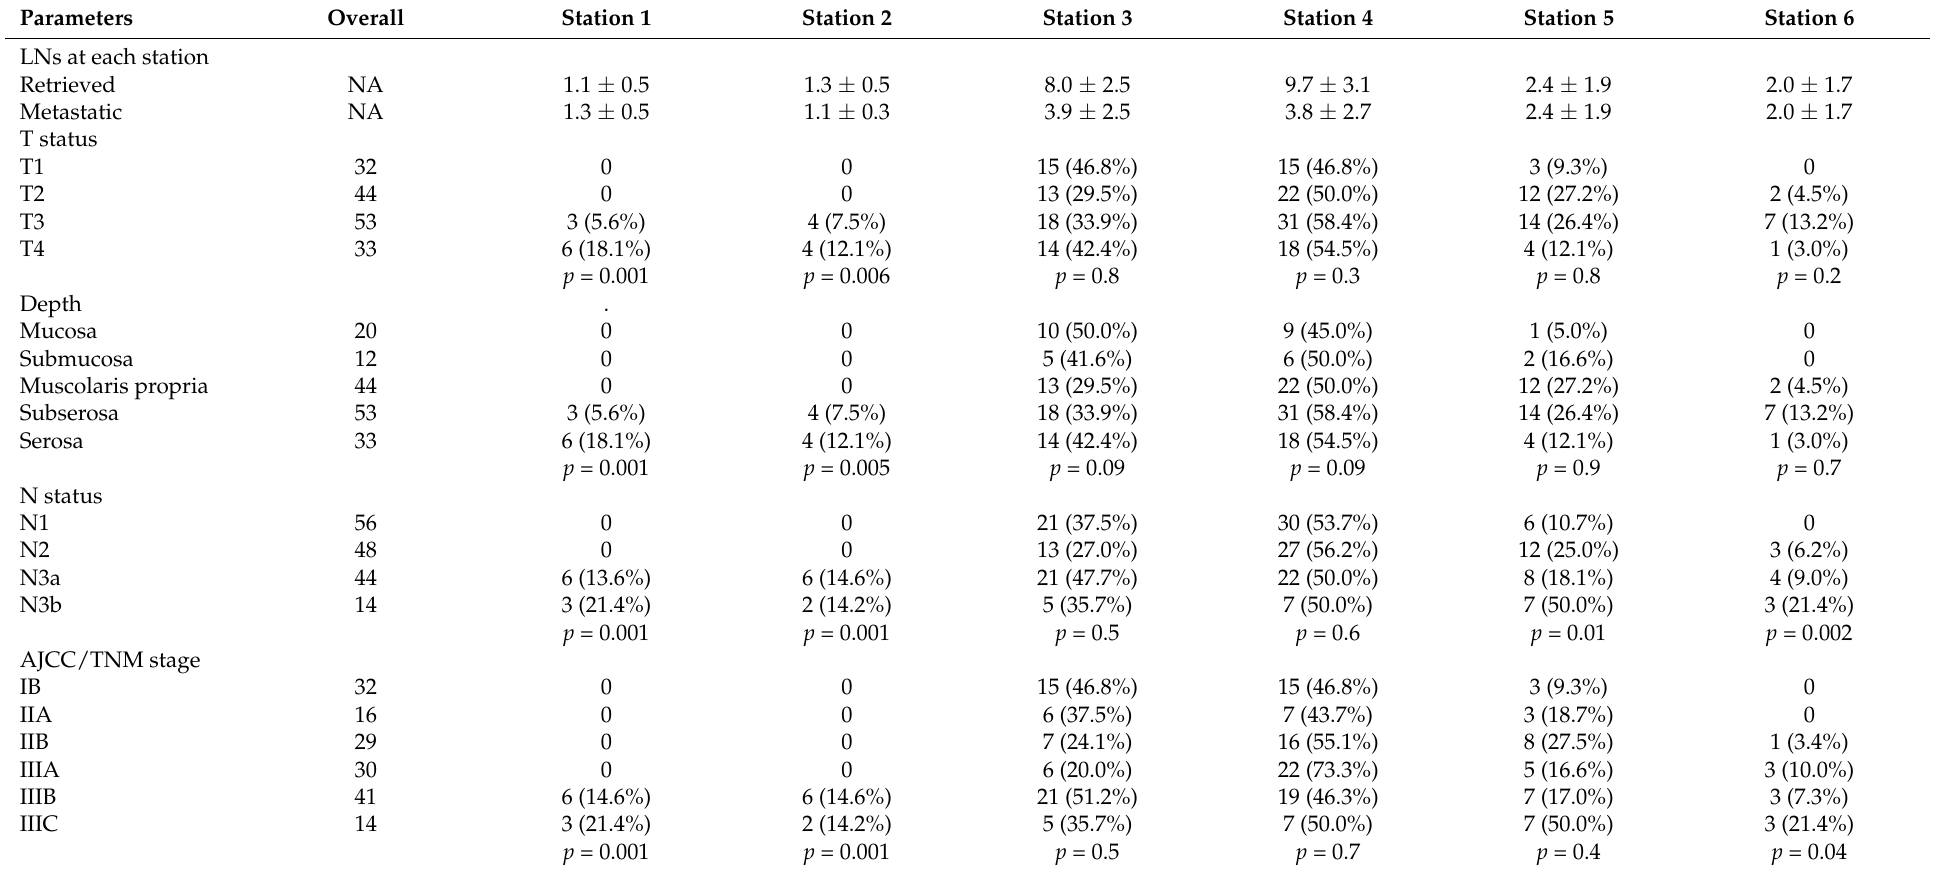
Values are mean ± SD. p values: comparison with values in overall patients. All the patients were included in all evaluations. Numbers in brackets represents percentage. LN: lymph node. M: mi dle-third. L: lower third. Gre: greater curvature. Less: lesser curvature. NA: not